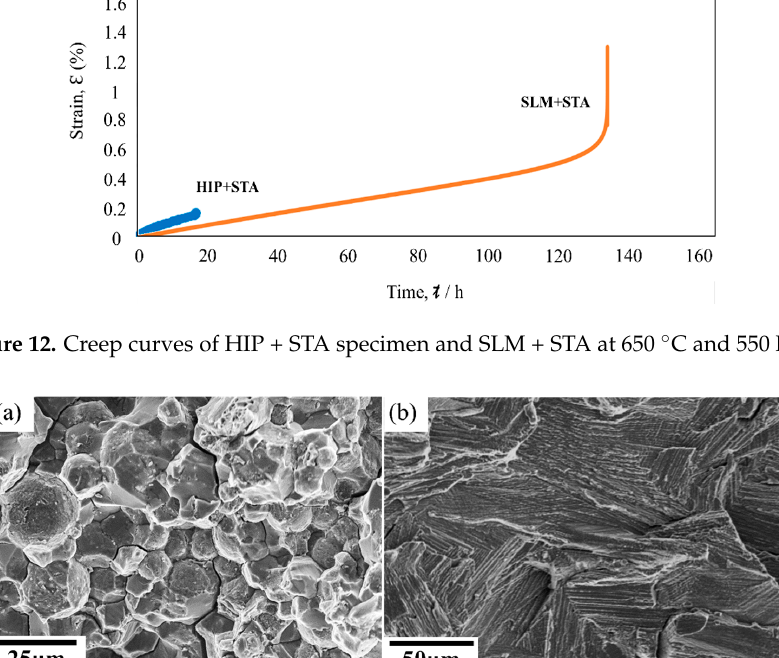
Figure 13. Fracture surfaces of ( a ) HIP + STA specimen and ( d ) SLM + STA specimen tested at 650 °C and 550 MPa.